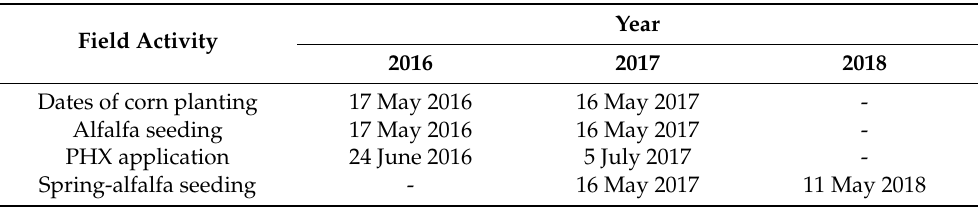
Table 1. Corn planting and alfalfa seeding and proxehadione (PHX) application dates for corn-alfalfa intercropping experiment conducted from 2016–2018 at Boone, IA,